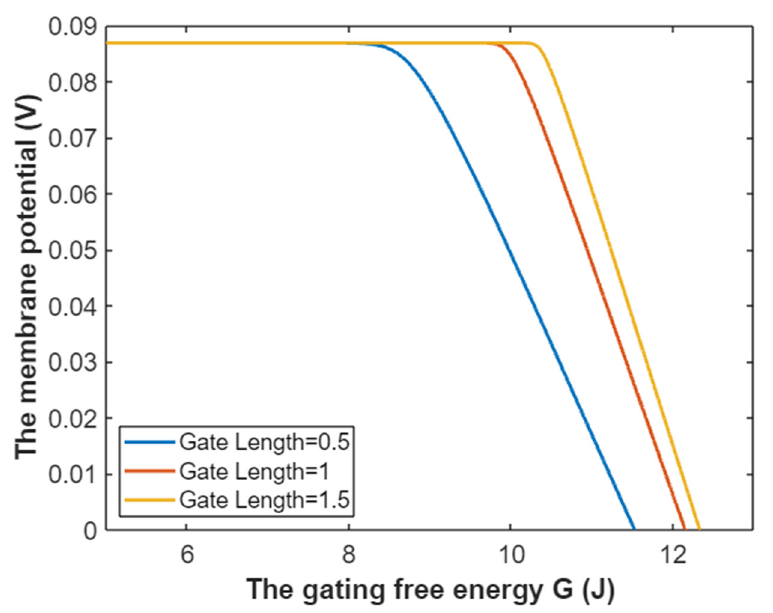
Figure 34. The relationship between gating free energy and the resting membrane potential under the influence of quantum tunneling of potassium ions.